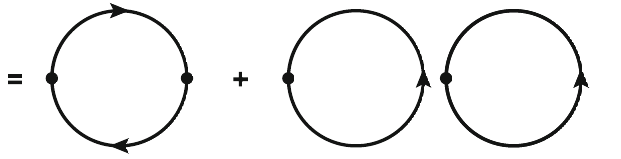
(cid:2) (cid:3) N 2 . The point represents the vertex and